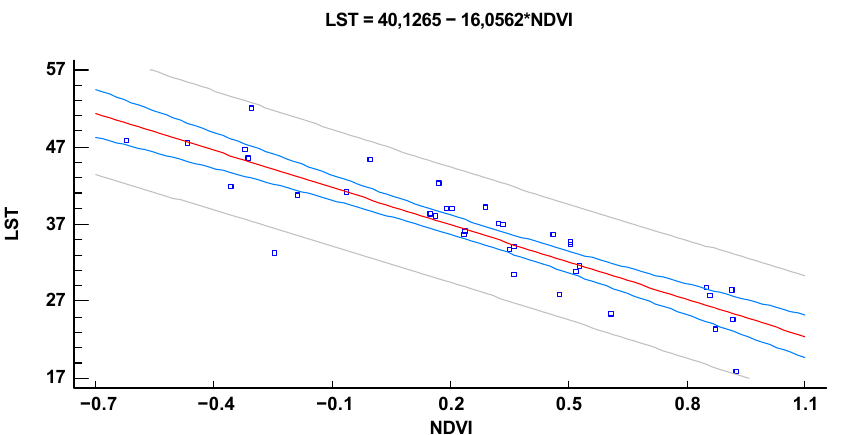
Figure 7. A-Scatterplot of LST and NDVI, B- Plot of the simple linear regression between NDVI and LST.